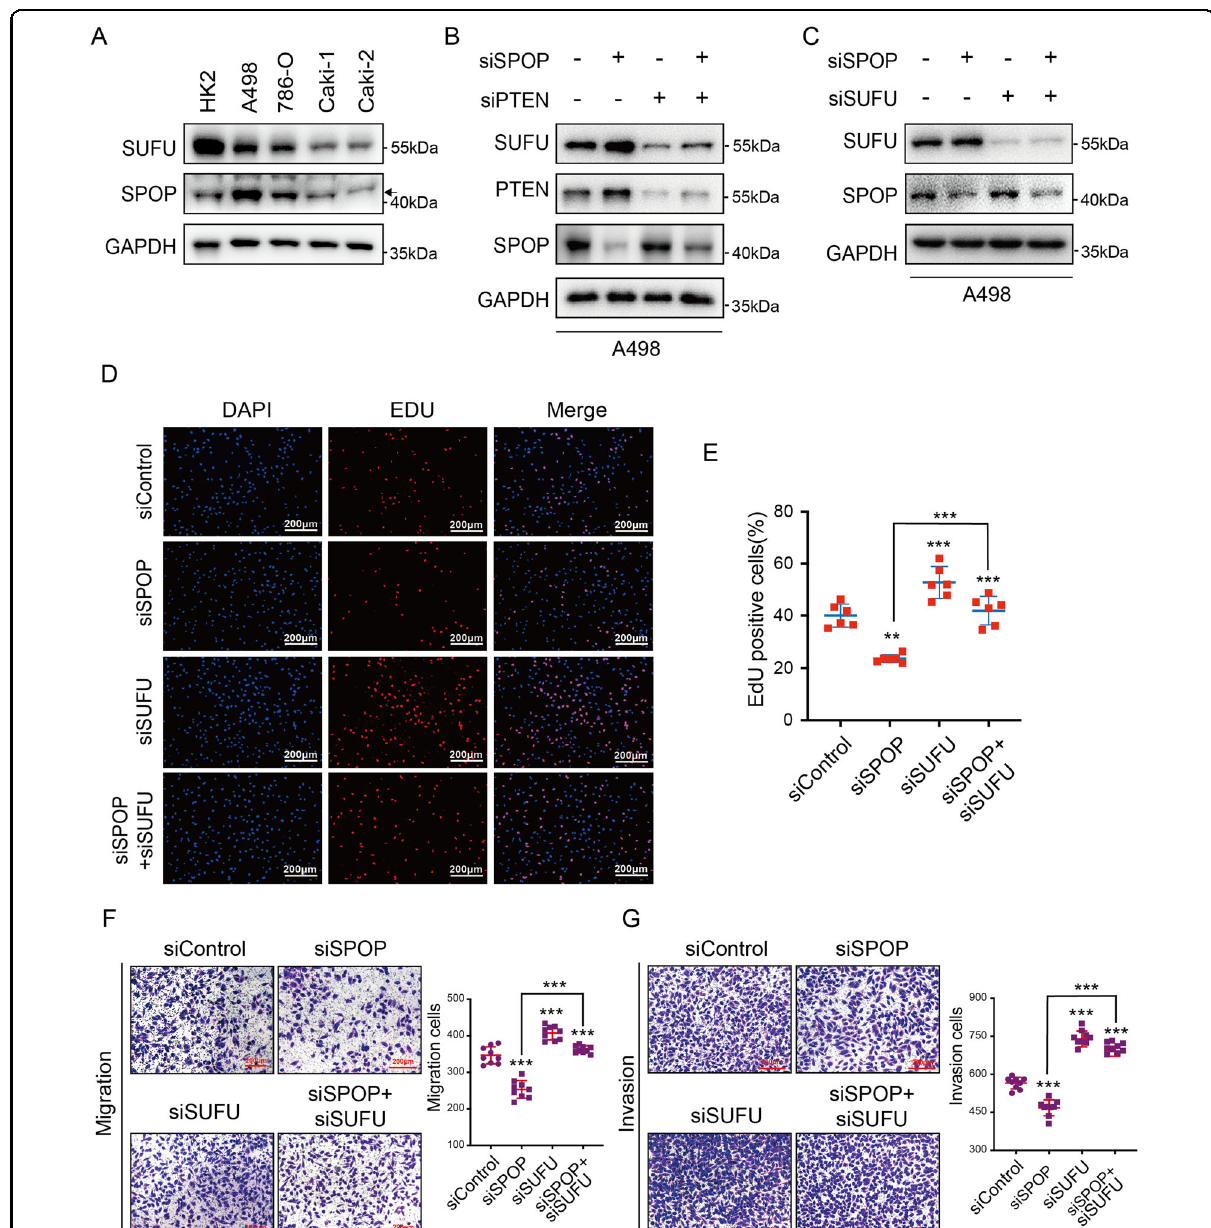
Fig. 5 SPOP downregulates SUFU to enhance tumorigenesis and progression in ccRCC. A The relative abundances of SPOP and SUFU proteins were detected by western blotting in the normal kidney cells HK2 and four ccRCC cell lines, such as A498, 786-O, Caki-1, and Caki-2. B The protein levels of SUFU, PTEN, and SPOP were examined by western blotting in A498 cells transfected with indicated siRNA. C Western blot analysis showed the levels of SUFU in A498 cells transfected with siSPOP and siSUFU . D , E Fluorescence images and percentage quanti fi cation of EdU incorporation assays were shown. F , G Transwell assays and the quanti fi cation of migrated and invaded cells were applied to evaluate the migratory and invasive capacities of A498 cells expressing siRNA. ** P < 0.01; *** P < 0.001; ns not signi fi cant (unpaired Student ’ s t